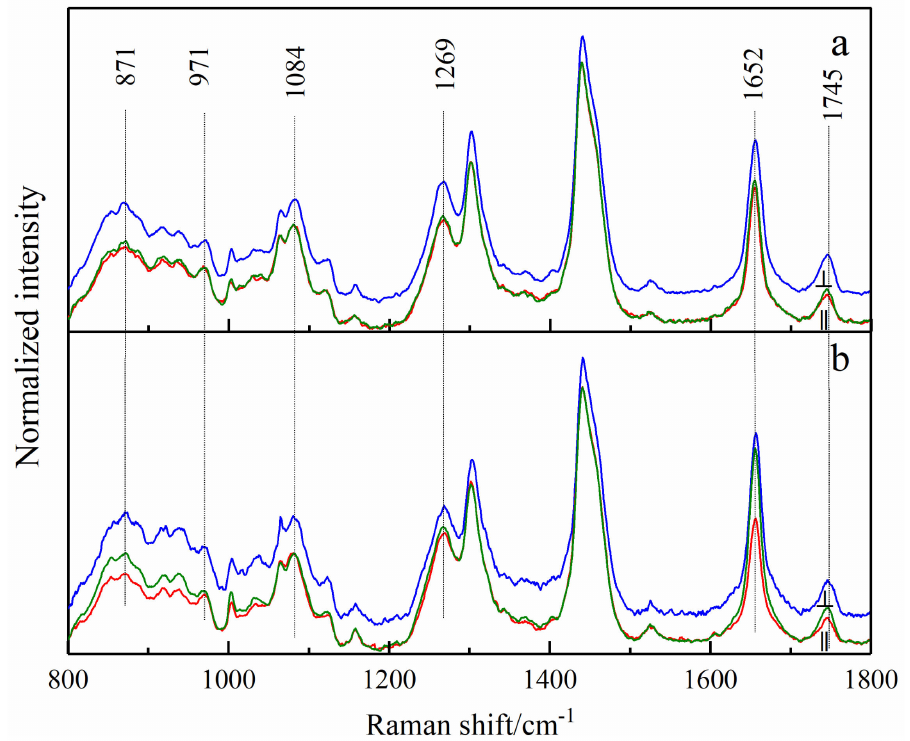
Figure 3. Polarized (red lines for parallel and green lines for perpendicular) and conventional (blue lines) Raman spectra of lipids collected from normal ( a ) and cancerous ( b ) tissues. All those shown are average Raman spectra, which were normalized to the band of 1442 cm − 1 to reduce the influence of tissue heterogeneity, respectively. Table 1. Raman band assignments of protein in normal and cancerous breast tissues [22–29]. Raman Shift (cm − 1 ) of Normal (Cancerous) Tissues Mode of Vibration Assignment 875 ν (C—C) Hydroxyproline in collagen Decrease, more obvious in polarized spectra 921 Proline in collagen